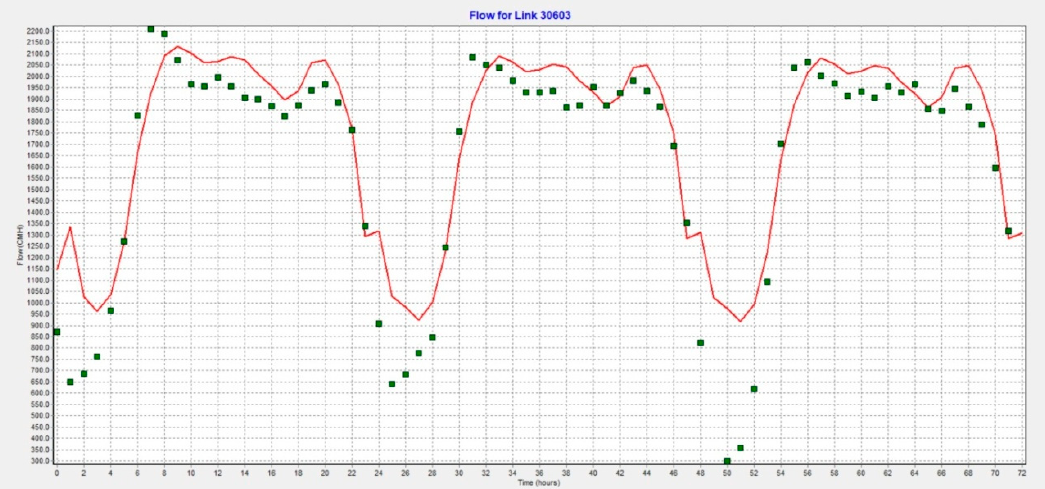
Figure 7. Results of Scenario II for Tanks E, east